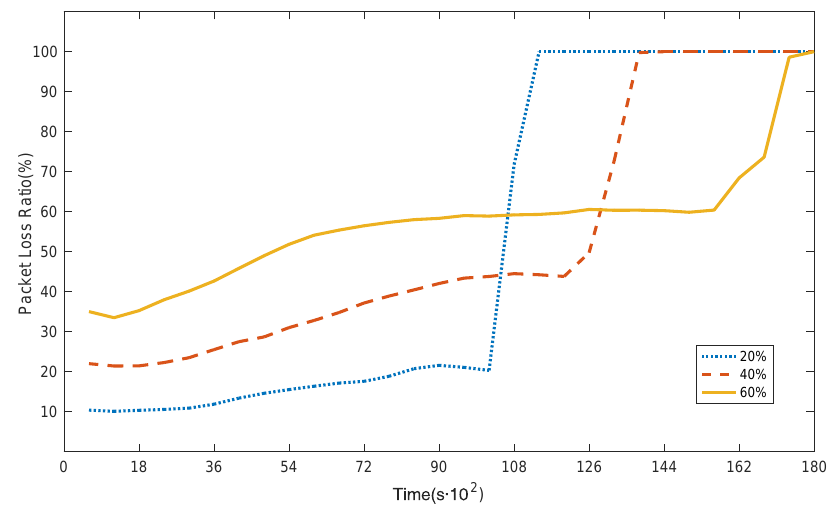
Figure 5. Packet loss ratios under different proportions of malicious nodes ( δ = 20%, 40%, and 60%) in information-aware secure routing